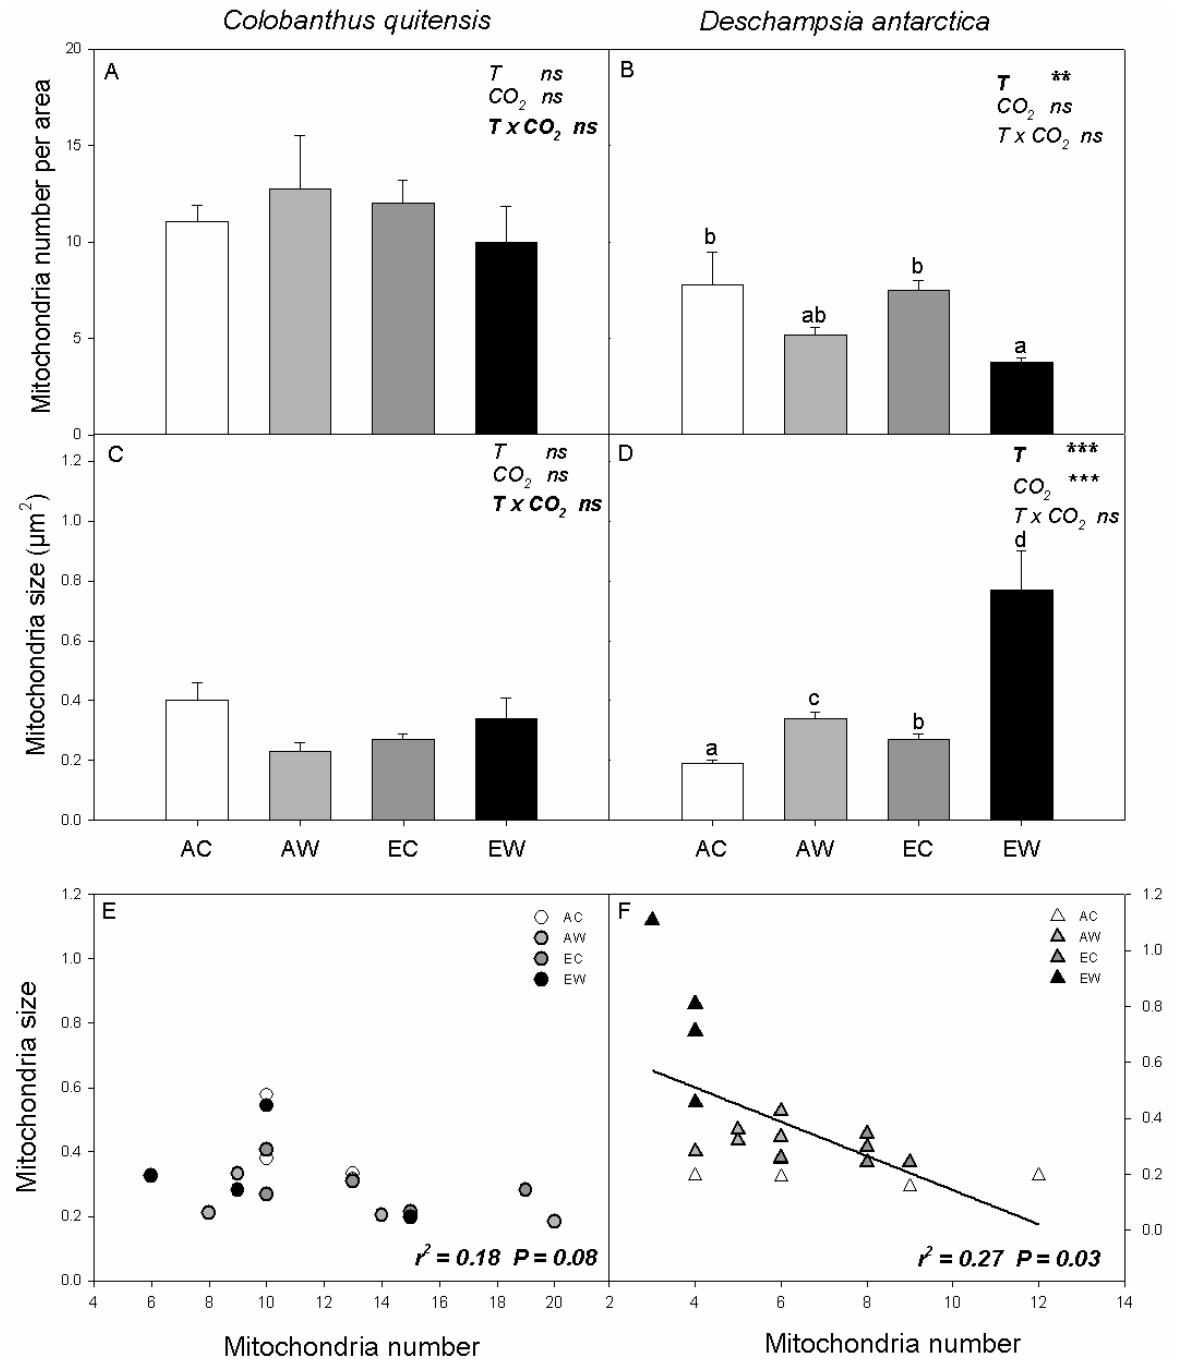
Figure 5. Leaf mitochondria structural changes in number, and size of mitochondria in a determined area of 171.8 µ m 2 and their correlation for C. quitensis ( A , C , E ) and D. antarctica ( B , D , F ) grown at AC (ambient CO 2 , control thermoperiod; white bar empty), AW (ambient CO 2 , warming thermoperiod; white bar hashed), EC (elevated CO 2 , control thermoperiod; grey bar), and EW (elevated CO 2 , warming thermoperiod; grey bar hashed). Values are means ± SEM ( n = 5). For each graph, the effect of thermoperiod (T), CO 2 environment (CO 2 ), and the interaction of thermoperiod and CO 2 (T x CO 2 ), with ns indicates no significance difference, * indicates p ≤ 0.05, ** indicates p ≤ 0.01, and *** indicates p ≤ 0.001. The factor with the largest effect size is indicated in bold.